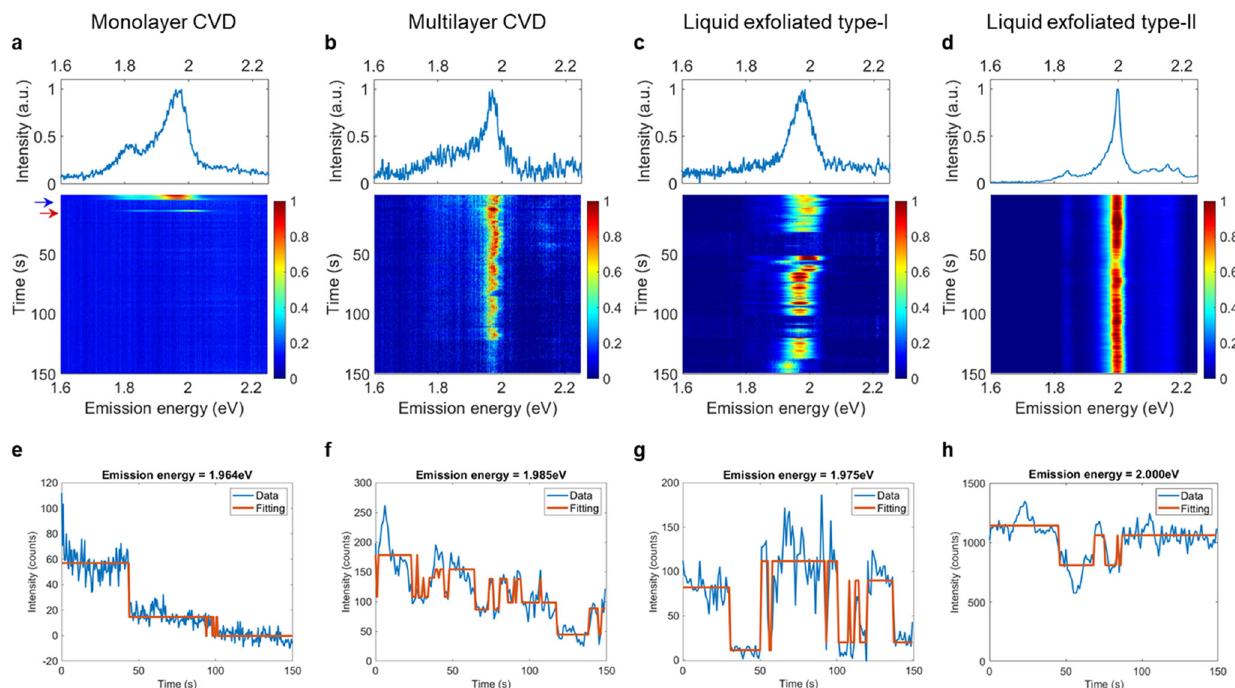
Fig. 1 Photostability of emitters of three common commercial hBN samples in the air. Photoluminescence (PL) spectra at time 0 s (upper panels) and time-traces from 0 s to 150 s (lower panels) with zero-phonon lines (ZPLs) near 1.98 eV in as-prepared ( a ) monolayer CVD, ( b ) multilayer CVD, and multilayer liquid exfoliated hBN with ( c ) type-I and ( d ) type-II emission. In the lower panel of ( a ), the blue arrow indicates a ZPL disappearing at approximately 5 s, while the red arrow highlights a new emission peak appearing at approximately 13 s, which is shifted + 50 meV from the original ZPL, before completely losing emission signal. Representative time-dependent intensity at a fi xed emission energy is plotted in blue lines of ( e ) monolayer CVD, ( f ) multilayer CVD, and multilayer liquid exfoliated hBN with ( g ) type-I and ( h ) type-II emission. Orange lines in ( e ) to ( h ) are fi tting with a cluster analysis, details of which are presented in Supplementary Note 1. In ( e ) monolayer CVD hBN, discrete bleaching steps are observed, where each step may correspond to an individual decay curve of total intensity (Supplementary Fig. 2b). As shown in Fig. 2a, the total intensity I of monolayer CVD hBN emitters (green line) could be fi tted with a single exponential decay function 16 (red dashed line):